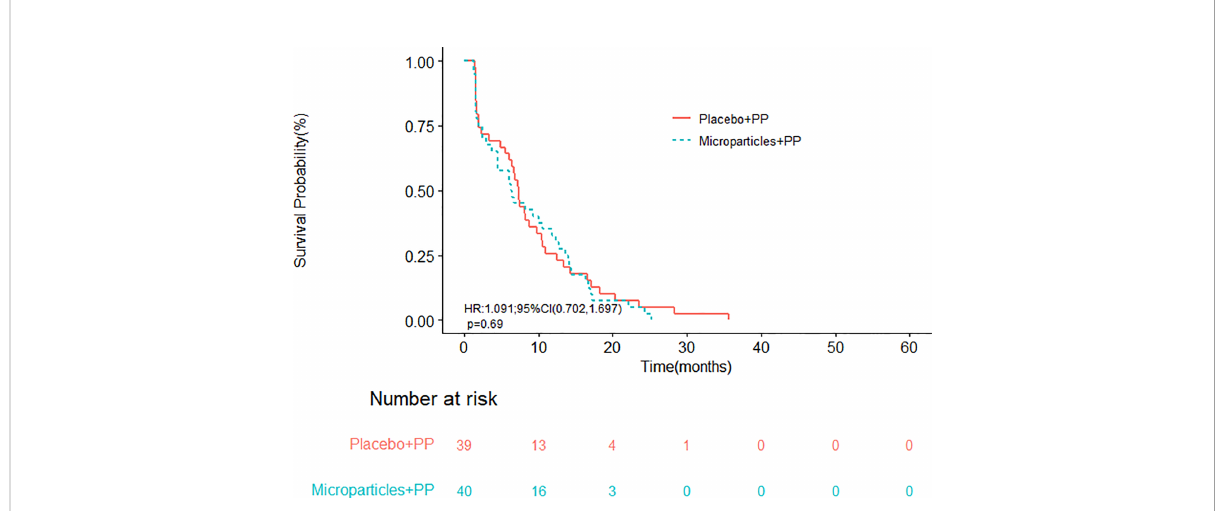
FIGURE 3 Progression-free survival of patients receiving the tumor cell-derived microparticles packaging methotrexate (TMPs-MTX) or saline combined with pemetrexed-cisplatin (PP) chemotherapy.